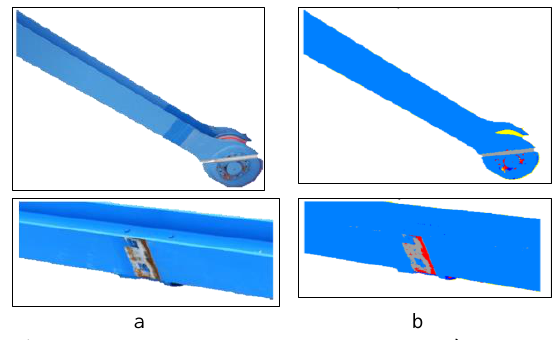
Figure 10 . Preliminary results on validation set. a) Original image, b) Prediction of Naïve Bayes